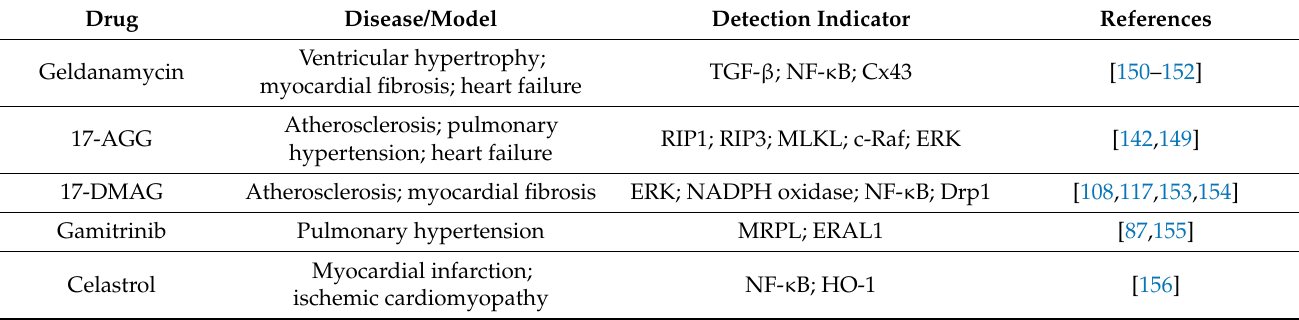
Table 1. HSP90 inhibitors associated with the treatment of cardiovascular disease. Disease/Model Detection